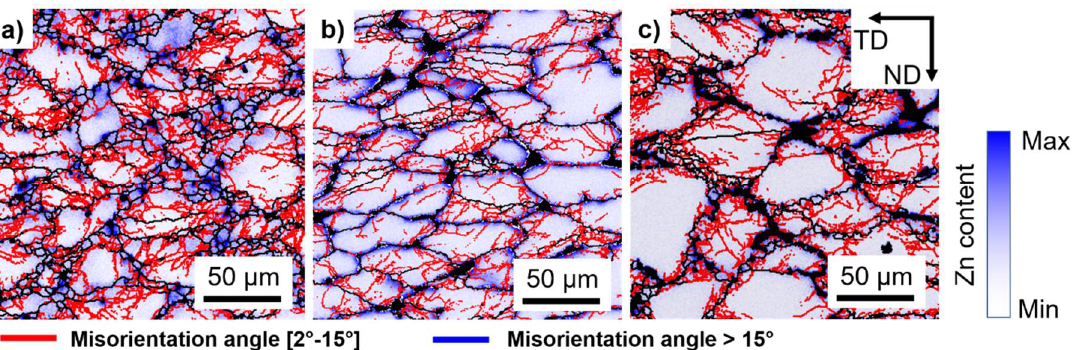
Figure 13. Energy-dispersive X-ray spectroscopy (EDXS) maps of Zn normalised for de deformed alloys at 300 °C and 0.0001 s −1 : ( a ) ZK40, ( b ) ZK40-CaO, ( c ) ZK40-Gd. Only α-Mg is indexed. Non-indexed regions are highly deformed regions or intermetallic compounds. Low and high angle grain boundaries are indicated by red and black lines, respectively. ND and TD indicate the compression and transversal directions, respectively.